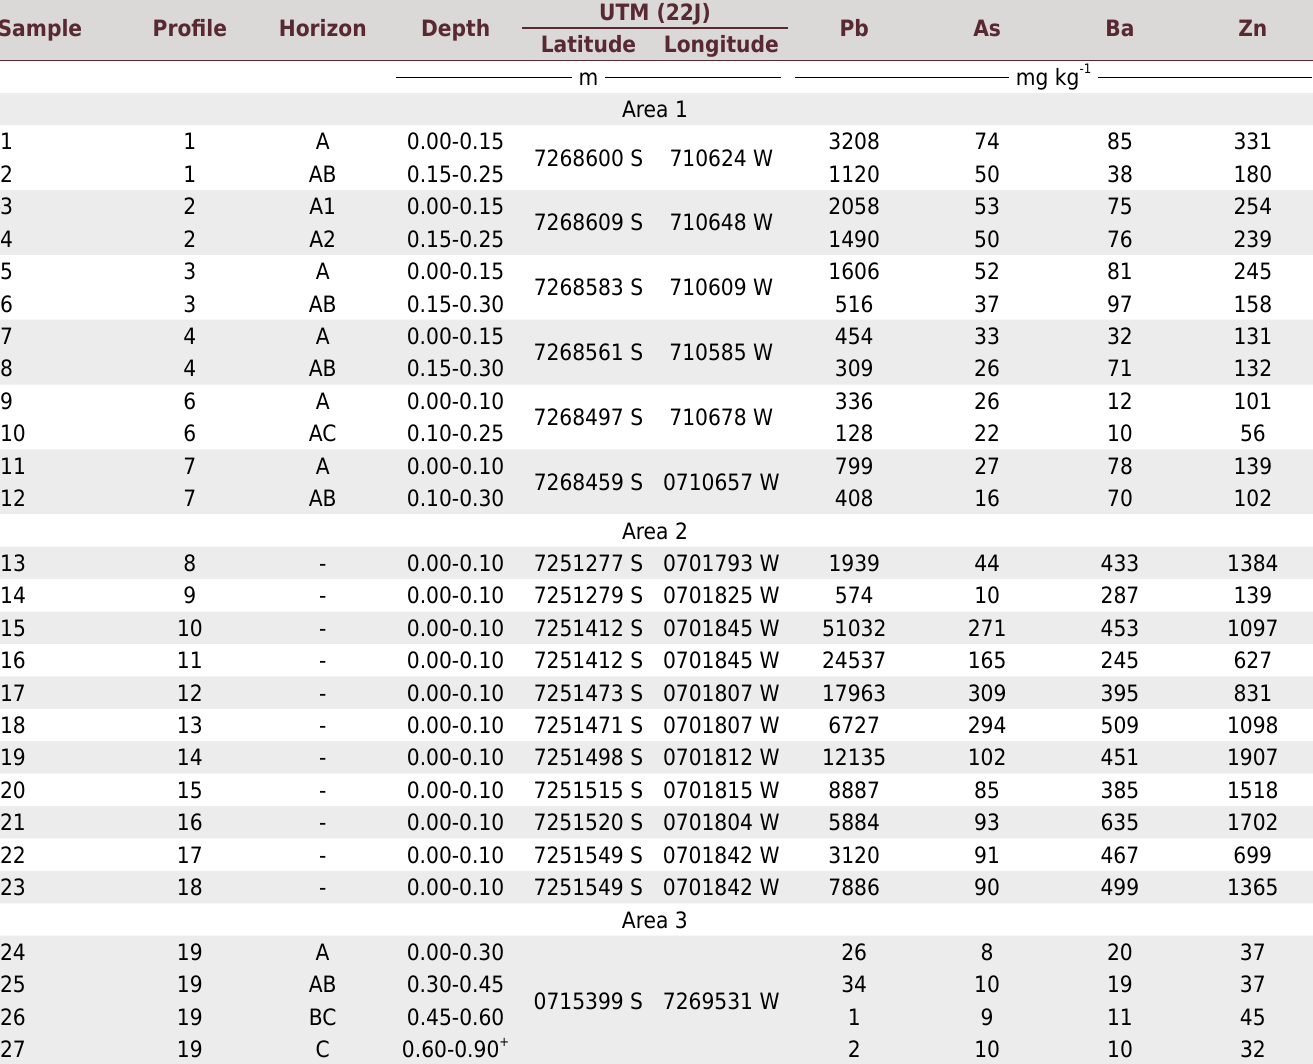
Table 1. General properties and total contents of Pb, As, Ba, and Zn (EPA 3052 - Usepa, 1997) in soils of areas 1, 2, and 3